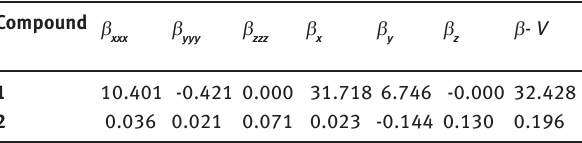
Table 6: Some selected components of the frequency-dependent ),;2( ωωωb − and V −b ( × 10 -30 esu) values at ω =0.04282 a.u. for 1 - 2 computed by TDHF method with 6-31G( d ) basis set.